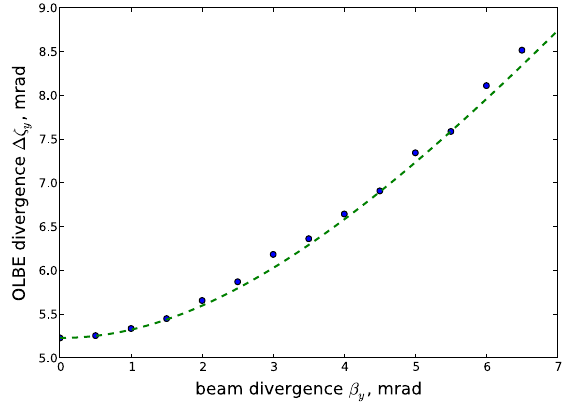
FIG. 6. Angular divergence of betatron emission in the nontrapped direction as a function of initial beam divergence. Blue dots show the simulation data and dashed curve corre- sponds to Eq. (23).